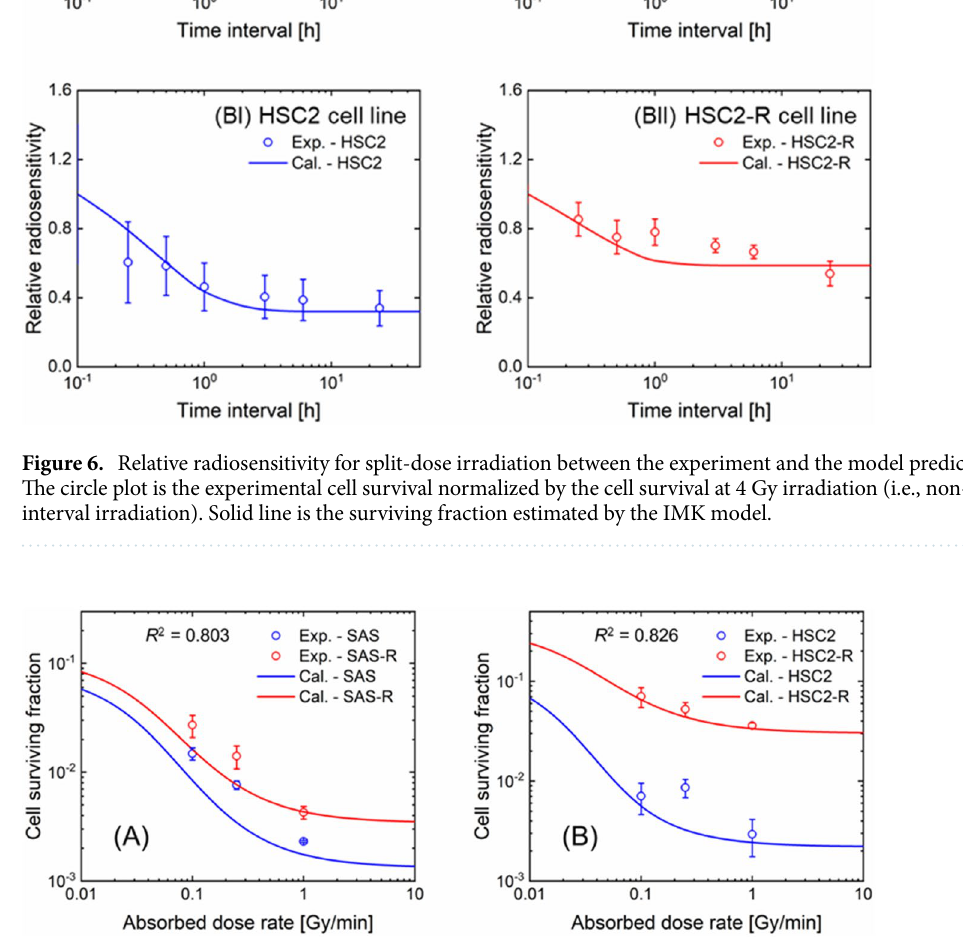
Figure 7. Dose-rate effects measured by experiment and predicted by the IMK model. The logarithmic scale of the relation between dose rate and cell survival. ( A ) is for SAS and SAS-R at a constant dose of 10 Gy, and ( B ) is for HSC and HCS2-R at a constant dose of 6 Gy. Blue and red circle plots are the experimental cell survival of non-resistant cells (SAS and HSC2) and resistant cells (SAS-R and HSC2-R), respectively, while blue and red solid lines are the cell survival of non-resistant (SAS and HSC2) and resistant cells (SAS-R and HSC2-R) estimated by the IMK